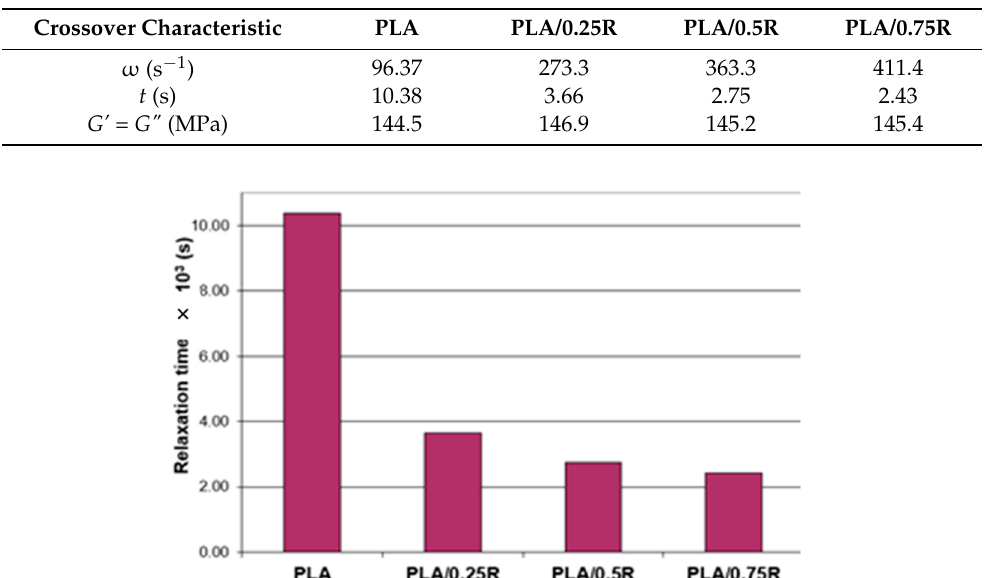
Table 4. Crossover frequency and crossover moduli values for PLA, and PLA/Rosemary blends.